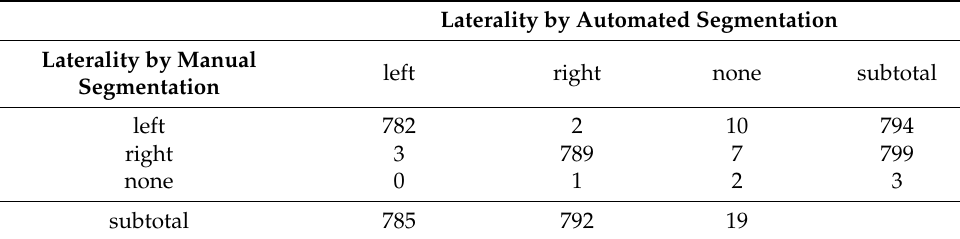
Table 2. Contingency table of laterality between automated and manual segmentations.